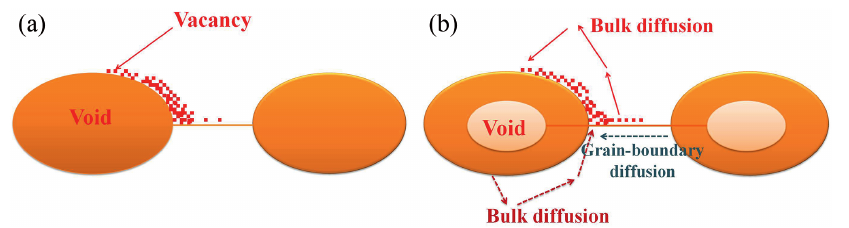
Figure 11: Diffusion mechanism for